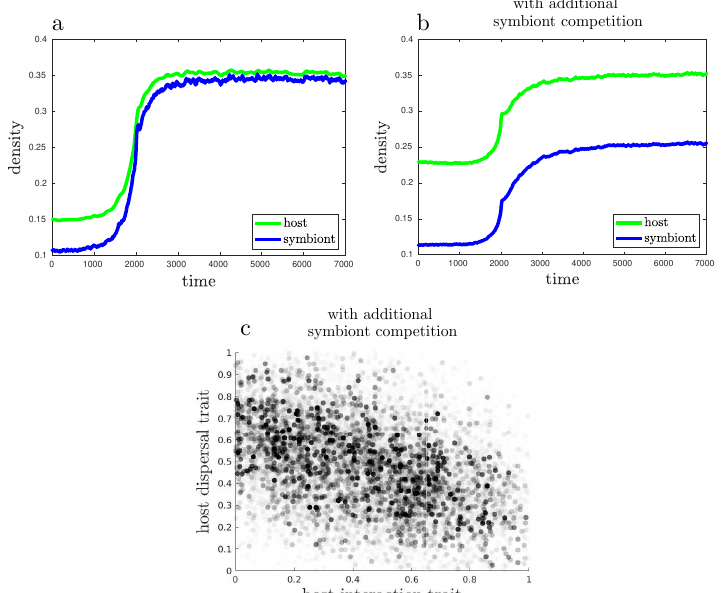
Figure SI.12. Effect of density-dependent competition between symbionts on host evolution. a) Symbiont and host densities after and before the transition, without density-dependent competition between symbionts. b) Symbiont and host densities after and before the transition, with density-dependent competition between symbionts. c) Distribution of host traits after the transition, with density-dependent competition between symbionts. To be compared with Figure 3b.